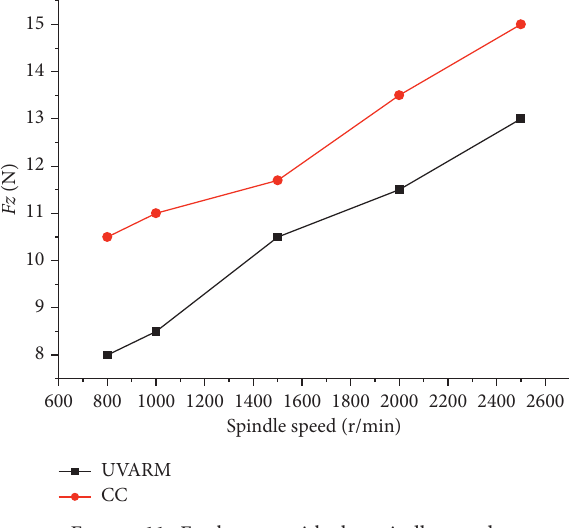
Figure 11: Fz changes with the spindle speed.